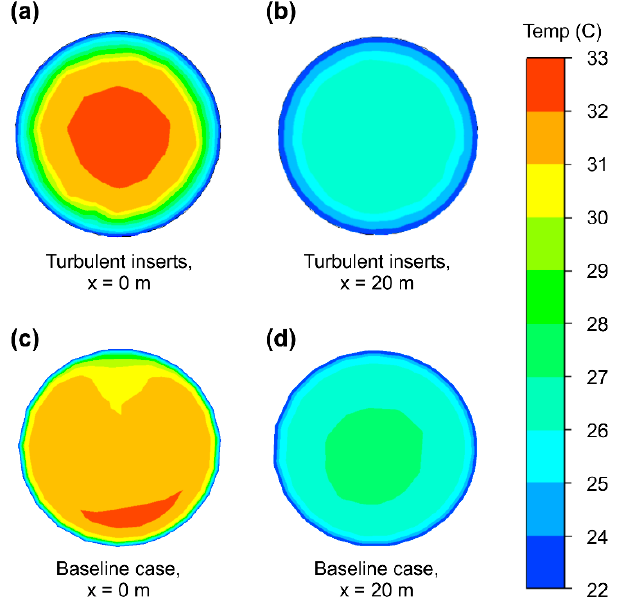
Figure 5. Temperature profiles at x = 0 m and x = 20 m for the baseline and turbulent insert cases.